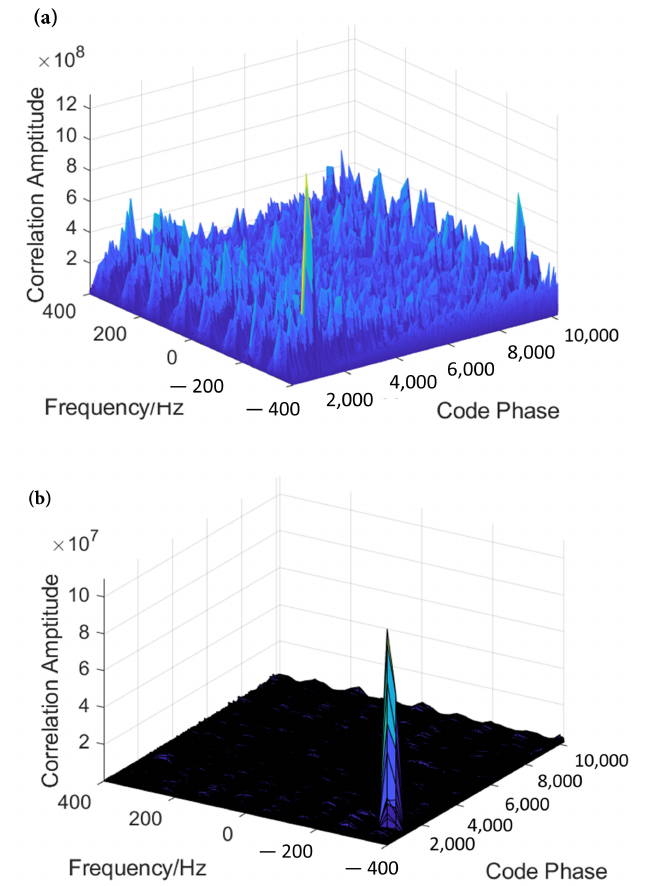
Figure 10. Mitigation performance of KL algorithm under pulse interference with different duty